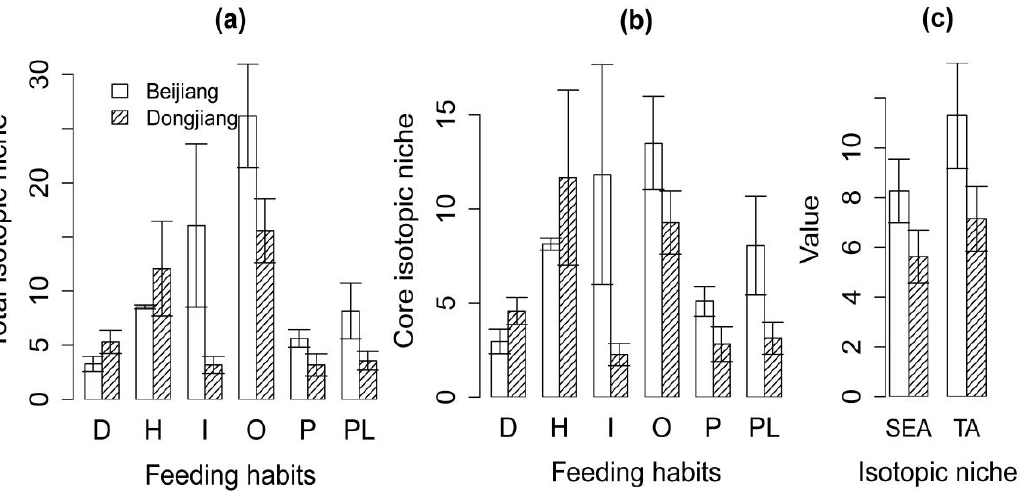
Figure 4. Differences in TA and SEA between the invaded Dongjiang River and the reference Beijiang River. ( a ) Difference in TA based on fish feeding habit. ( b ) Difference in SEA based on fish feeding habit. ( c ) Overall difference in TA and SEA. In the sampled fish communities, IDiv showed no obvious difference between rivers. IEve ( t = −1.66, p = 0.048) and IRic ( t = −2.77, p = 0.032) in the invaded Dongjiang River were significantly lower than the reference Beijiang River (Figure 5). The IUni ( t = 2.19, p = 0.034) in the invaded Dongjiang River was significantly higher than the reference Beijiang River (Figure 5).